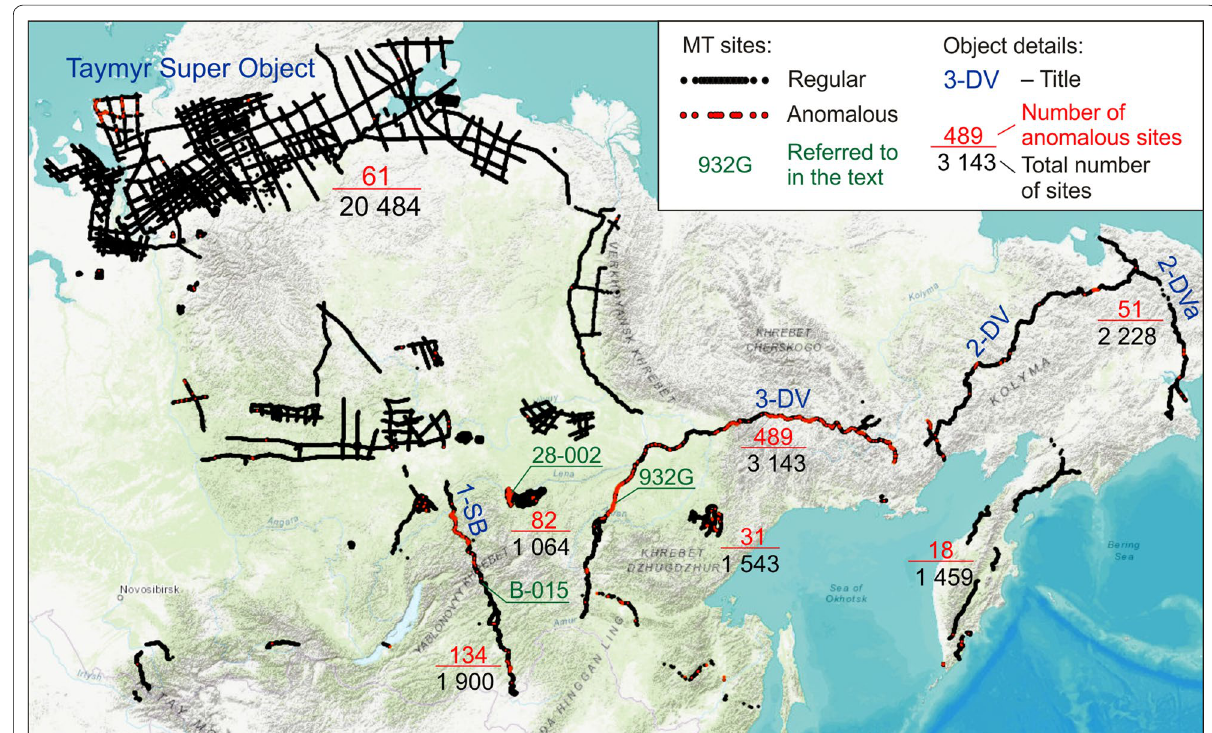
Fig. 15 East Russian part of the Nord-West Ltd. onshore MT/BBMT database employed in the